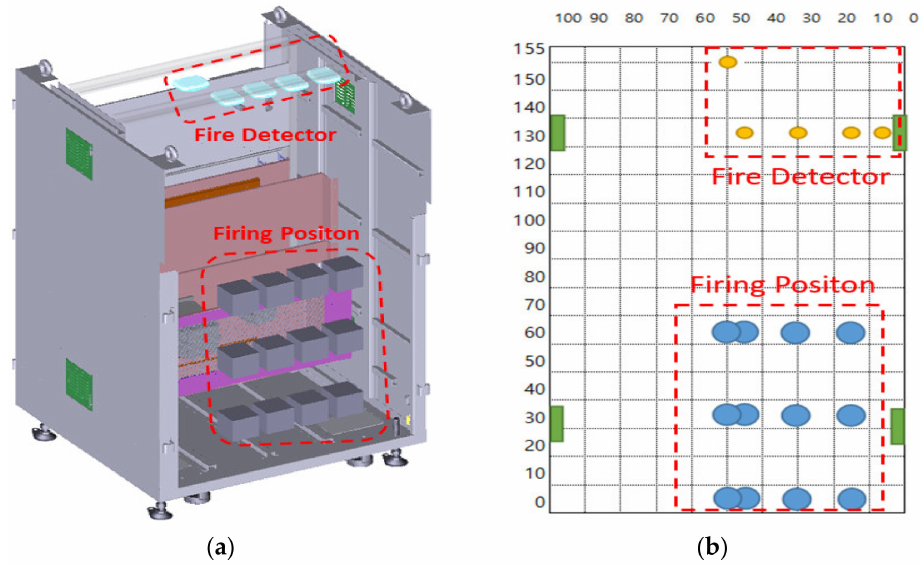
Figure 8. Distribution board drawing. ( a ) The 3D drawing; ( b ) fire origin and sample